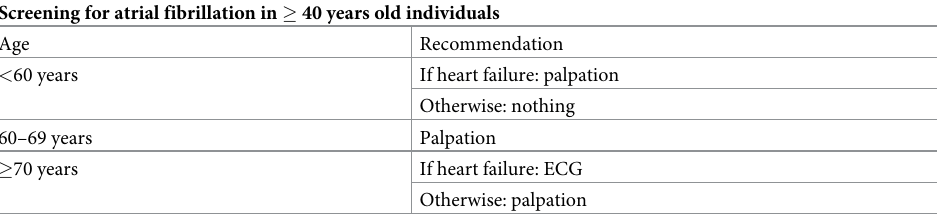
Table 4. Practical summary of the algorithm to indicate pulse palpation (and if positive ECG) or ECG (without previous pulse palpation) to detect atrial fibrillation in primary